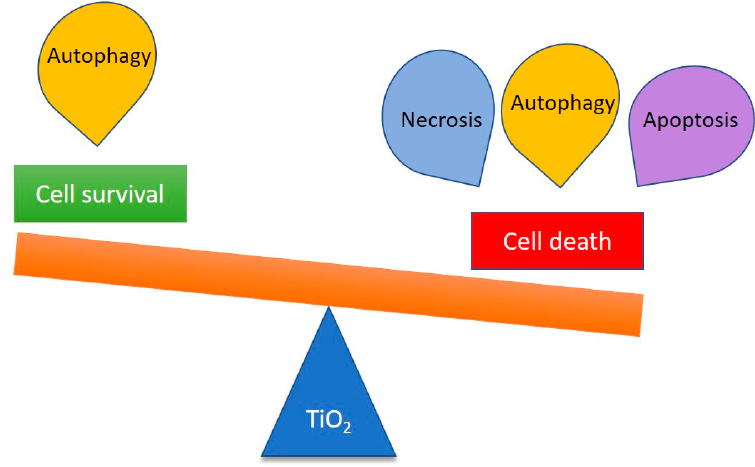
Figure 3. Influence of TiO 2 NPs on the cell fate.